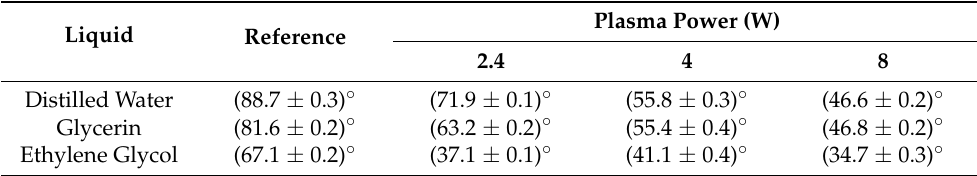
Table 3. Wetting contact angles of PP materials (depending on plasma